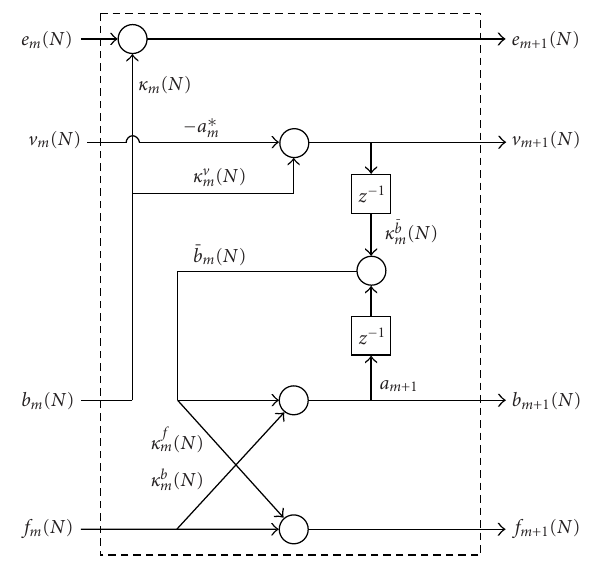
Figure 2: A lattice